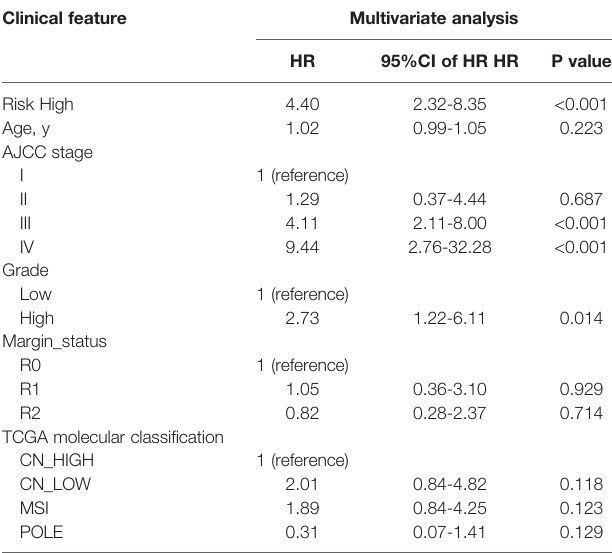
TABLE 3 | Multivariate Cox regression analyses for identifying clinicopathological parameters related to EC patients ’ OS. Clinical feature